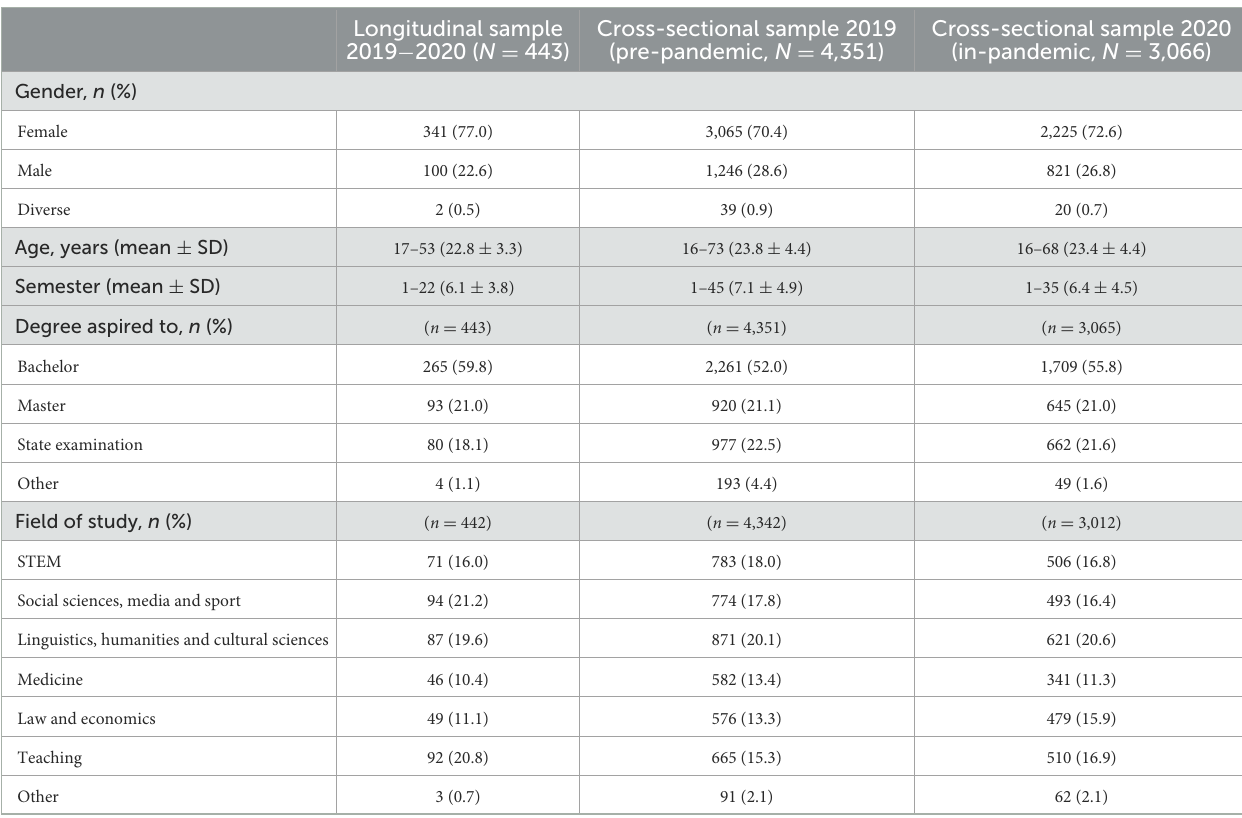
TABLE 1 Characteristics of the study